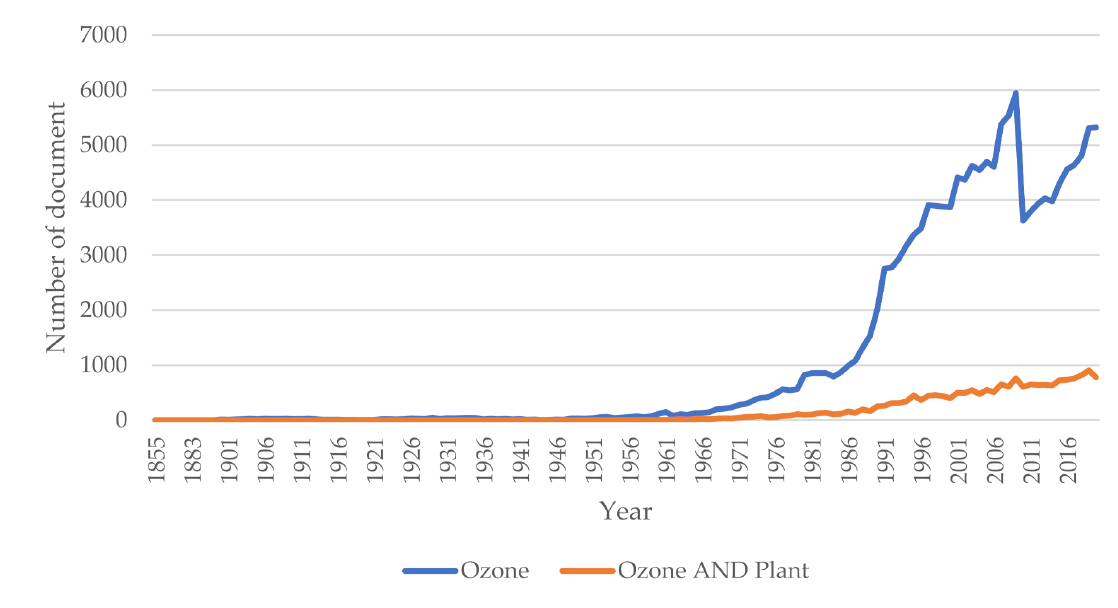
Figure 1. Trends in publications on ozone research in absolute terms (blue line) and in the plant field (orange line) in the period